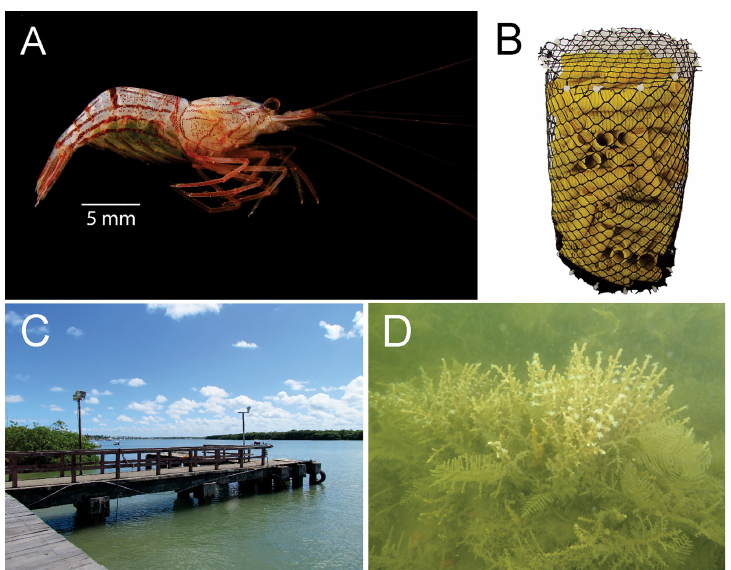
Fig 1. Lysmata vittata (Stimpson, 1860) and sampling sites. (A) Lateral view of ovigerous hermaphrodite. (B) Artificial Refuge Structures (ARS) used to obtain the shrimp. (C) Pier at Vaza-Barris estuary, Brazil. (D)